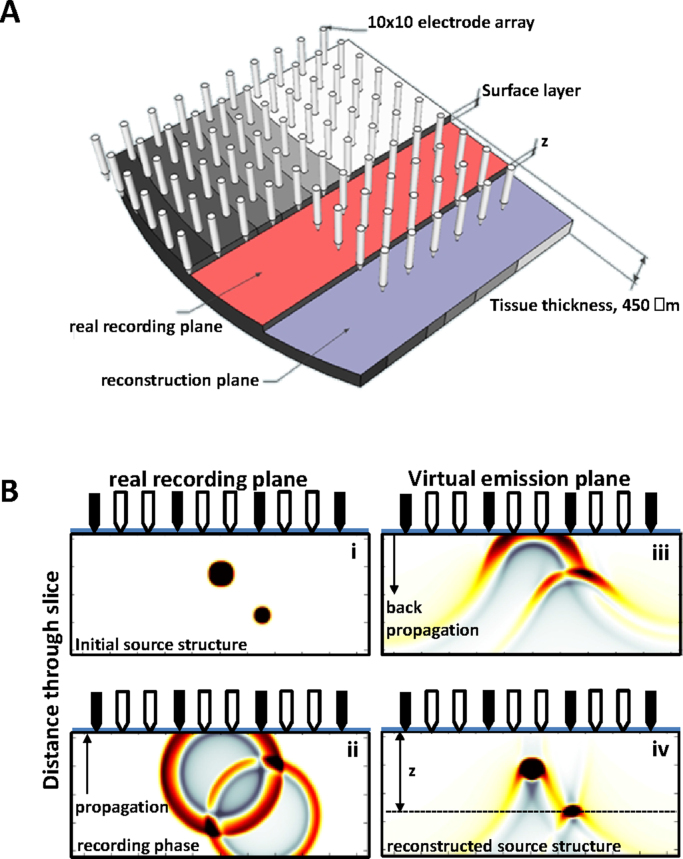
Basic application of near-field electromagnetic (NEH) holography. (A) Cartoon illustrating the data collection paradigm and its relation to the near-field dimensions used. Recordings of neocortical tissue voltage were taken with a 10 × 10, square array of silicon electrodes with inter-electrode distance of 0.4 mm. Arrays were placed on the upper cut surface of the tissue (the real recording plane in the figure) with the leftmost column of electrodes aligned to the pial surface. The reconstruction plane used to estimate electromagnetic properties of on-going activity in the tissue was set between ca. 65 and 265 μm into the slice (distance z) to obtain optimal spatial resolution (see Fig. 3). (B) Example of electromagnetic field source reconstruction using the experimental approach outlined in (A) simulated using the K-Wave toolbox (Treeby and Cox, 2010). Two circular sources of differing size and distance from the slice surface (real recording plane) were simulated. (ii) Electrical activity projecting from these sources was recorded as voltage change by the nearby electrodes (black arrows) and interpolated to two virtual electrode points (white arrows) between each real electrode using the Papoulis–Gerchberg algorithm [12]. (iii) Real and interpolated data is projected back into the tissue from the recording plane (now a virtual emission plane) using a k-space propagator and filter (see text) to estimate the direction and intensity of electromagnetic energy flow (Poynting vector, Fig. 2) from tissue properties. (iv) Accurate source structure reconstructed using this holographic process is dependent on the physical relationship between original source location and the chosen reconstruction plane.